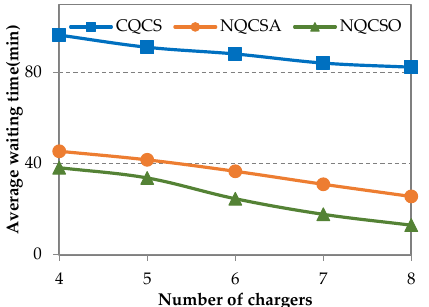
Figure 8. Average waiting time of charged EVs for CSs with different numbers of chargers in different charging situations.